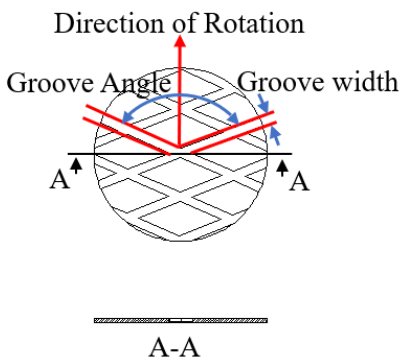
Figure 1. Schematic diagram of the reticular texture. Table 1. Reticular texture size parameters.